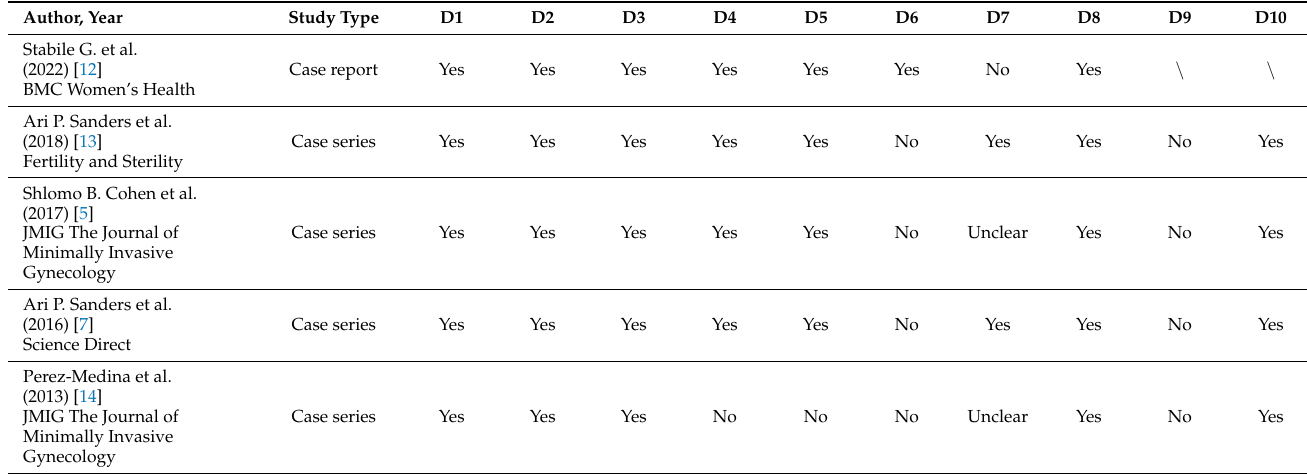
Table A1. JBI Critical Appraisal Checklist for